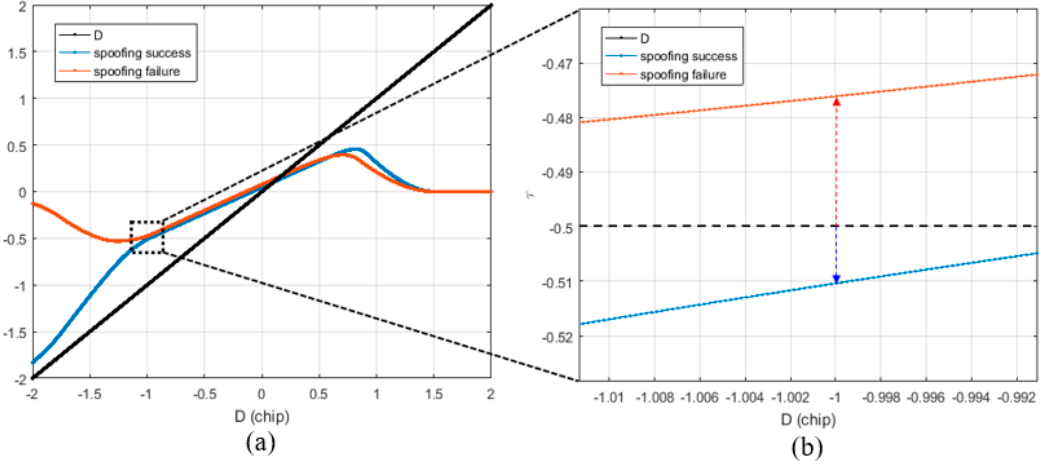
Figure 6. Different τ values at D is − 1 according to the spoofing attack success or failure. ( a ) Overall τ histories; ( b ) τ values at D is − 1.